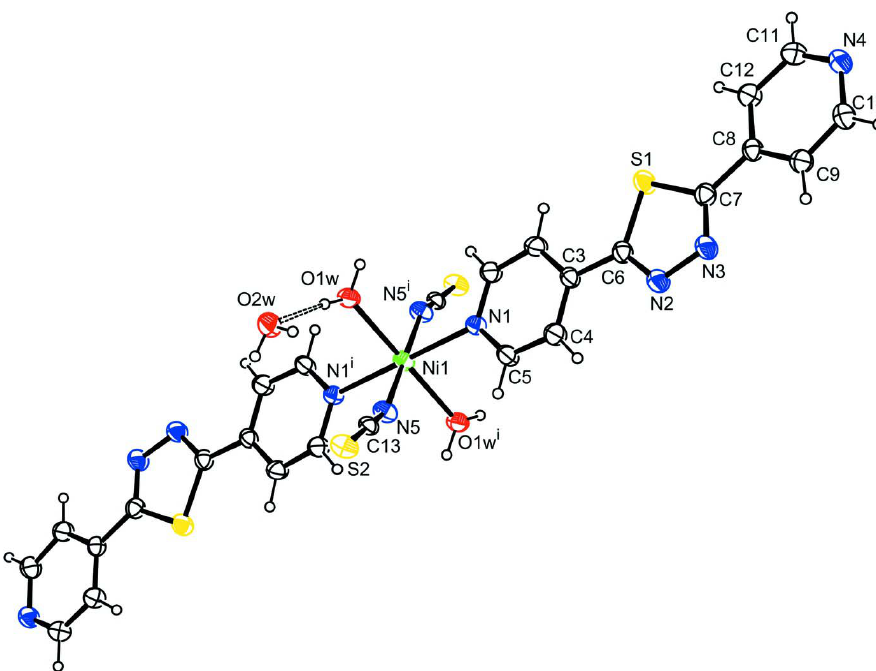
Figure 1 The ORTEP plot of (I), showing the atom-labeling scheme. Displacement ellipsoids are drawn at the 30% probability level. H atoms are represented as small sphere of arbitrary radii. H bond is shown as dashed line. [Symmetry code: (i) 1- x , 1- y , 1- z